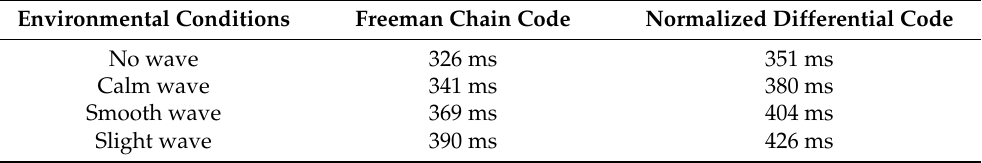
Table 5. Chain code acquisition time comparison.